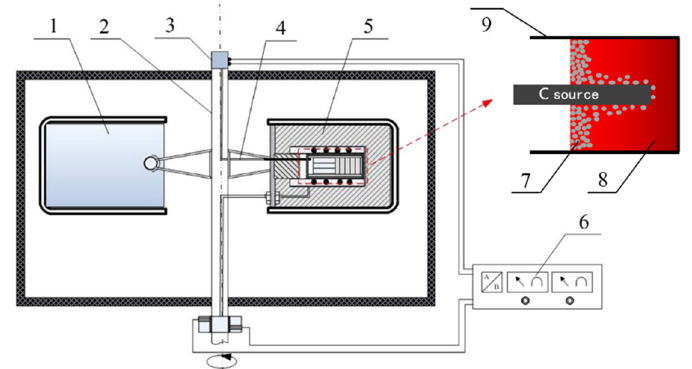
Figure 4. Sketch map of the centrifugal apparatus: 1 counterweight, 2 centrifugal axis, 3 conductive slipping, 4 thermocouple, 5 insulating layer, 6 temperature controller, 7 TiC x particles, 8 Cu-Ti melt, 9 graphite crucible.